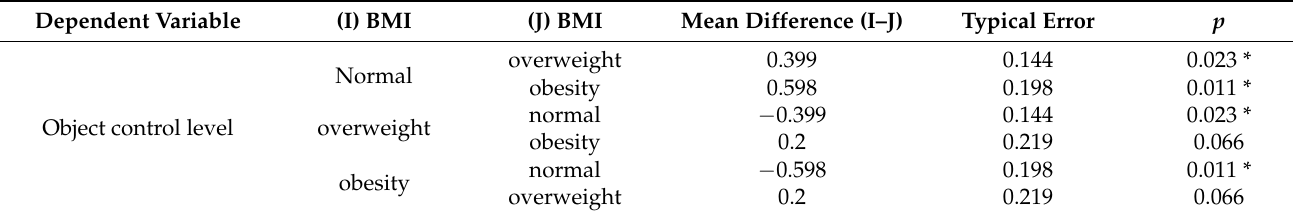
Table 5. Significant differences in the level of mobile management between groups of BMI.